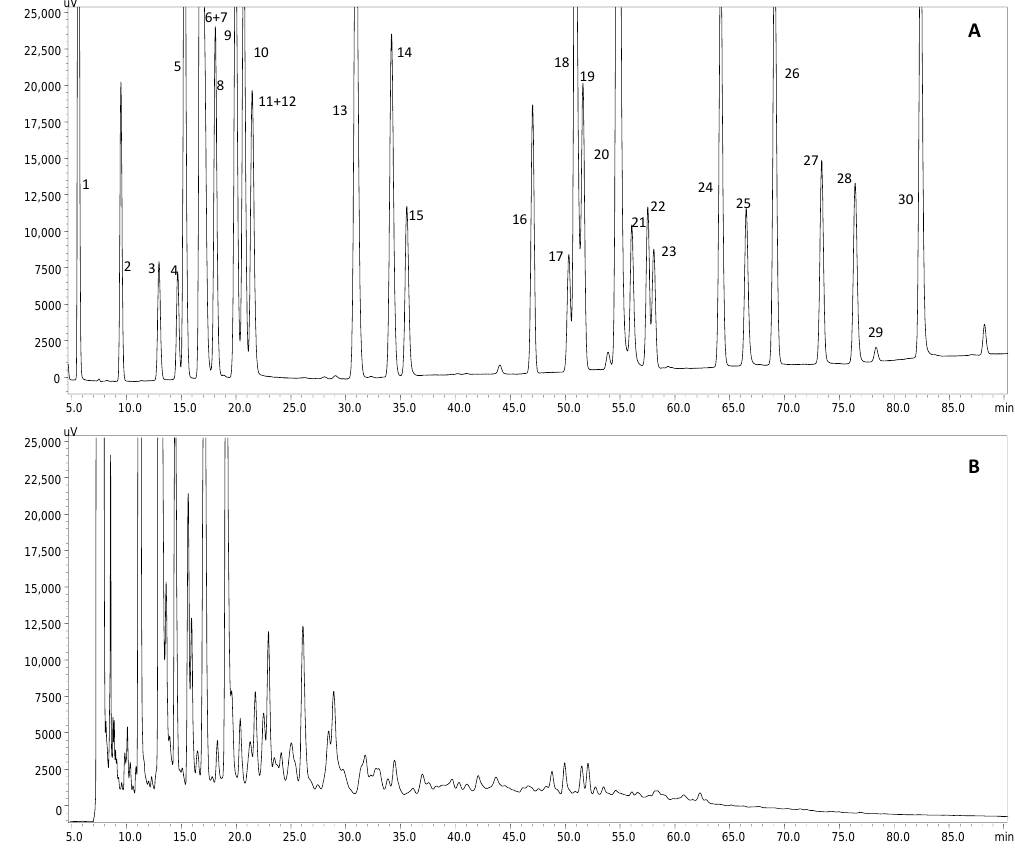
Figure 2. HPLC chromatograms at 280 nm for ( A ) polyphenols standard mixture and ( B ) Tinta Roriz subcritical water extract at 250 °C; peak identification: (1) gallic acid, (2) protocatechuic acid, (3) (+)-catechin, (4) 4-hydroxyphenilacetic acid, (5) 4-hydroxybenzoic acid, (6) 4-hydroxybenzaldehyde, (7)